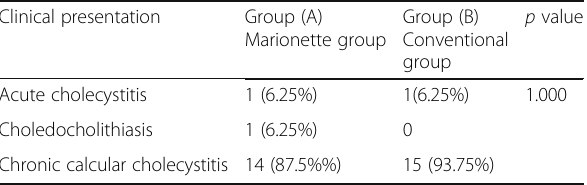
Table 2 Clinical presentation Clinical